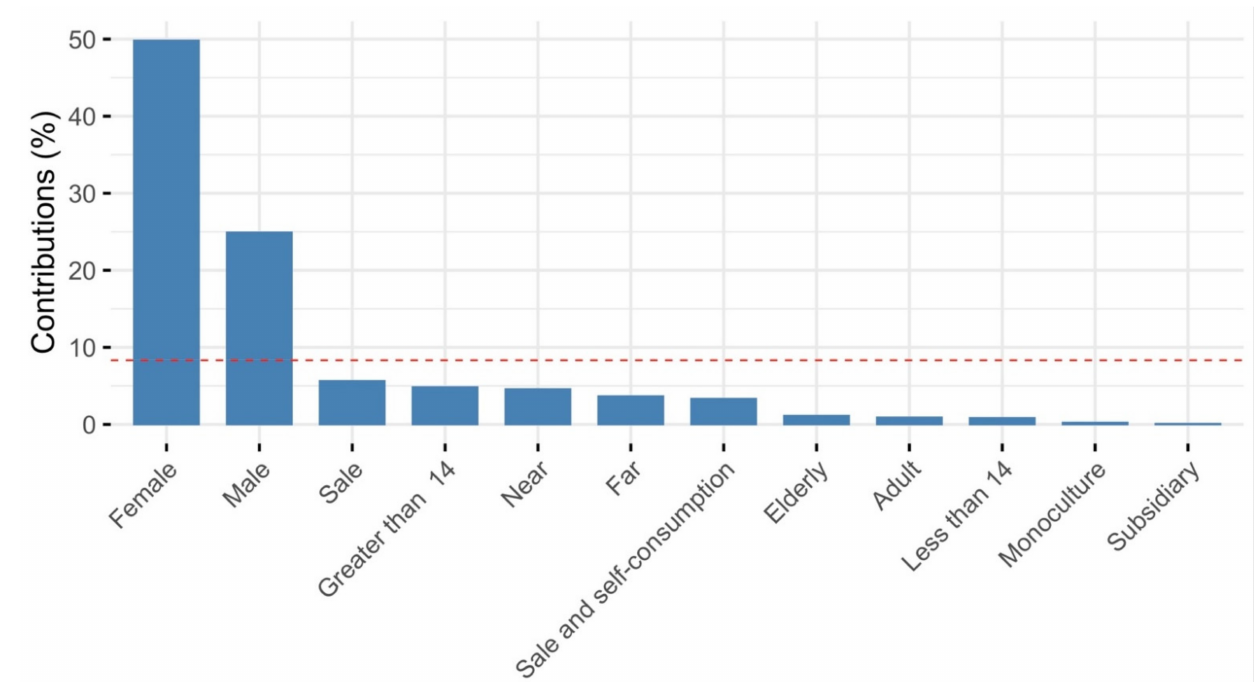
Figure A4. Contribution of variables to dimension